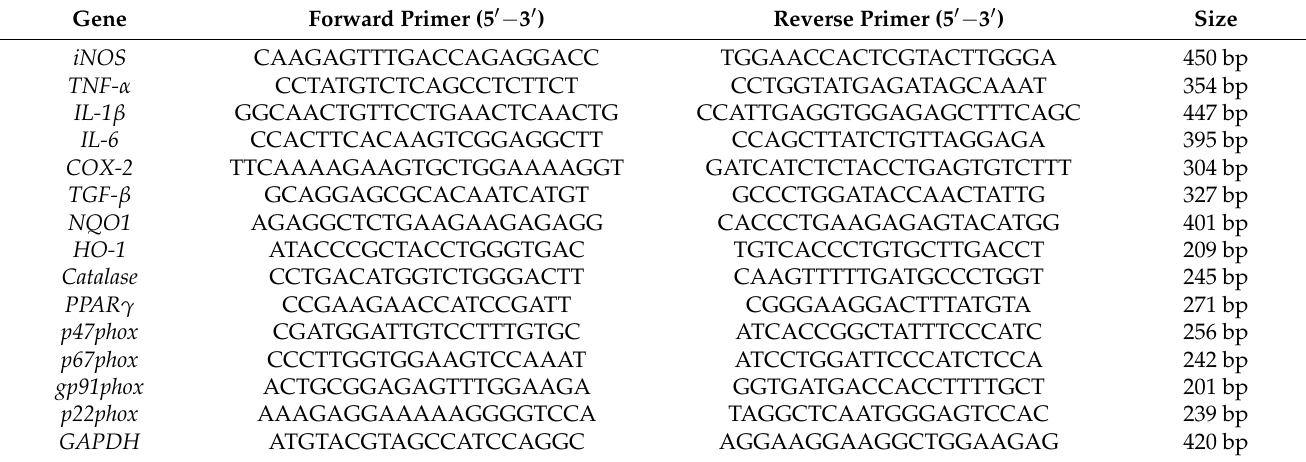
Table 1. Primer sequences used for